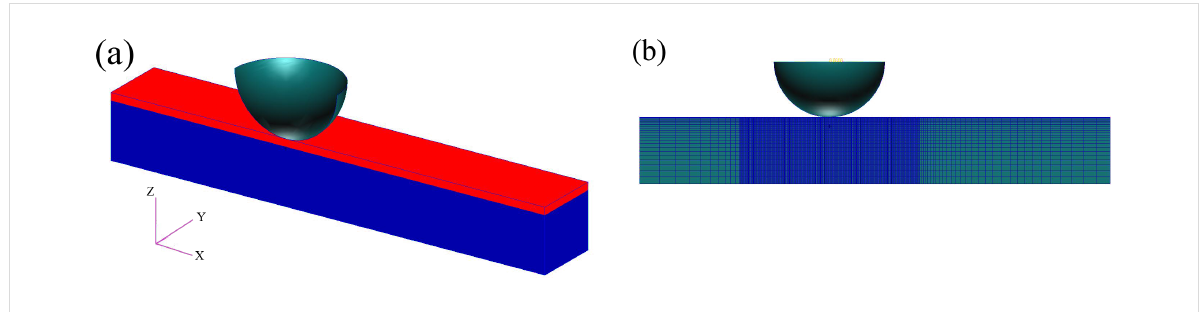
Figure 11: Model used for finite element calculations, for 7 nm titania film thickness. (a) Substrate is seen in blue and titania film in red (b) Mesh distri- bution of the elements.